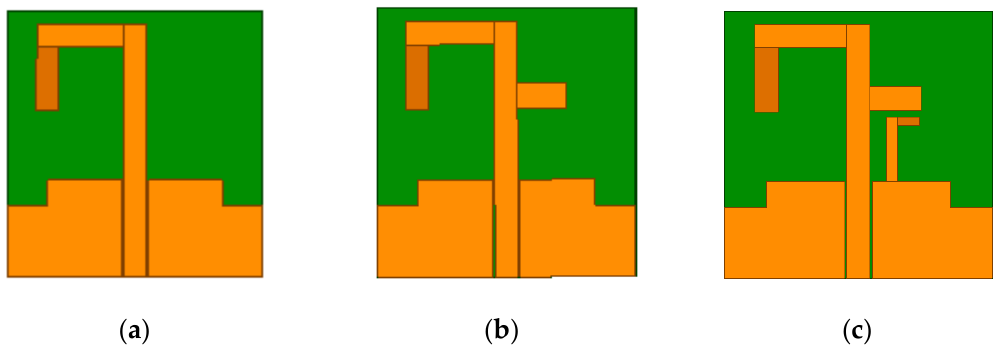
Figure 3. Evolution of the proposed design. ( a ) Ant #1. ( b ) Ant #2. ( c ) Proposed antenna.